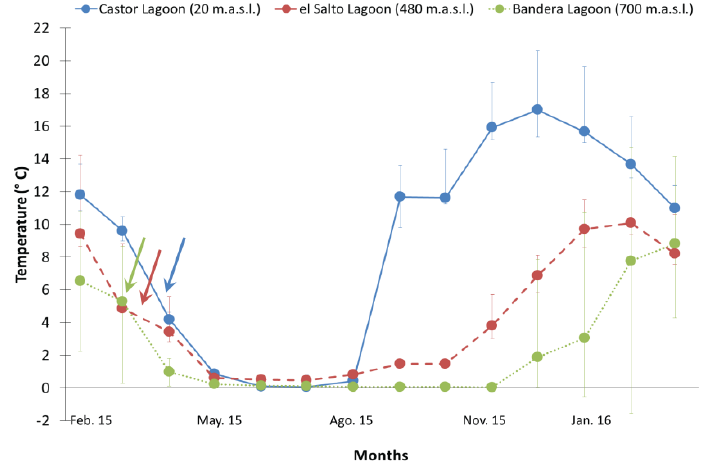
Figure 3. Monthly mean temperatures (±SD) retrieved from loggers installed in lagoons at different elevations in the Róbalo River watershed. Color lines indicate different lagoons, and colored arrows indicate the time of collection at each elevation.